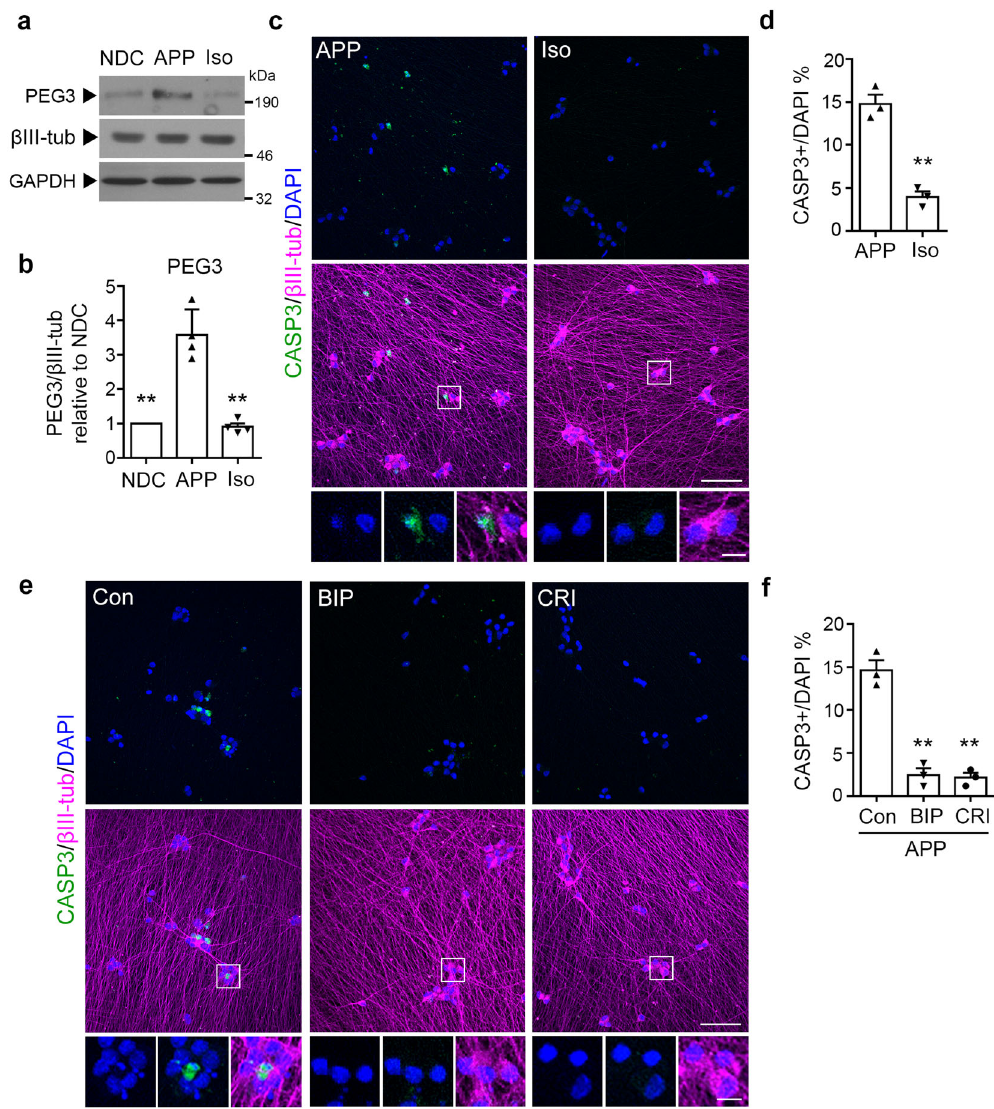
Fig. 4 PEG3 dysregulation and neuronal death are rescued in gene-corrected isogenic neurons. a Western blot analysis of PEG3 protein in nondemented control (NDC), APP duplication parent (APP), and APP copy number-corrected isogenic (Iso) neurons. b Quanti fi cation of PEG3 expression levels normalized to that of β III-tubulin ( β III-tub) and relative to those in the NDC neurons. c Immuno fl uorescence images showing CASP3 (cleaved caspase 3)- positive apoptotic cells with pyknotic condensed nuclei in APP and Iso neurons at 28 days in vitro. Scale bars: 50 and 10 μ m. d Percentage of CASP3- positive apoptotic cells in all neurons. The proportion of apoptotic cells was lower in Iso neurons than that in APP neurons. b , d Values are mean ± SEM ( n = 3 independent biological replicates per line; ** P < 0.01 vs. APP line; Student ’ s t -test). e Immuno fl uorescence images showing CASP3-positive cells in APP neurons at 28 days in vitro treated with vehicle control (Con), 100 μ M BIP-V5 (Bax inhibitor peptide V5), or 5 μ M CRI (cytochrome C release inhibitor) for 7 days. Scale bars: 50 and 10 μ m. f Percentage of CASP3-positive apoptotic cells among all neurons. The proportion of apoptotic cells was lower in BIP-V5- or CRI-treated neurons than that in Con neurons. Values are mean ± SEM ( n = 3 independent biological replicates per line; ** p < 0.01 vs. Con neurons; Student ’ s t